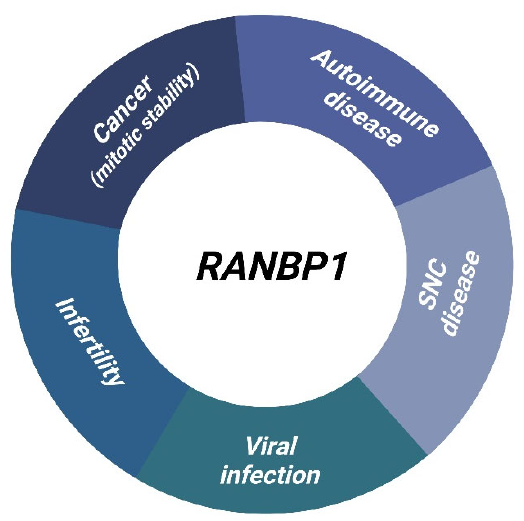
Figure 5. RANBP1 involvement in human